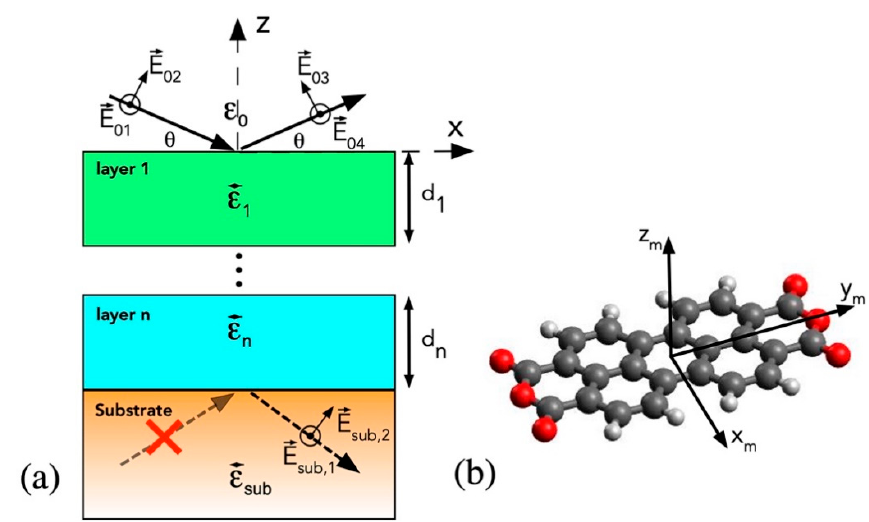
Figure 1. ( a ) Sketch of sequence of layers, each described by a complex dielectric tensor and a thickness d n . The layers are delimited by vacuum on top and by a semi-infinite substrate at the bottom, which is typically (but not necessarily) described by an isotropic material. A representation of the possible impinging and reflected electric fields are given, with xz being the scattering plane. E 01 and E 04 are the components of the fields parallel to the surface plane (perpendicular to the scattering plane—s-polarization for the incoming field), and E 02 and E 03 are the components of the fields laying in the scattering plane (p-polarization for the incoming field). ( b ) 3,4,9,10-Perylene-tetracarboxylic dianhydride (PTCDA) molecule with its principal axes.